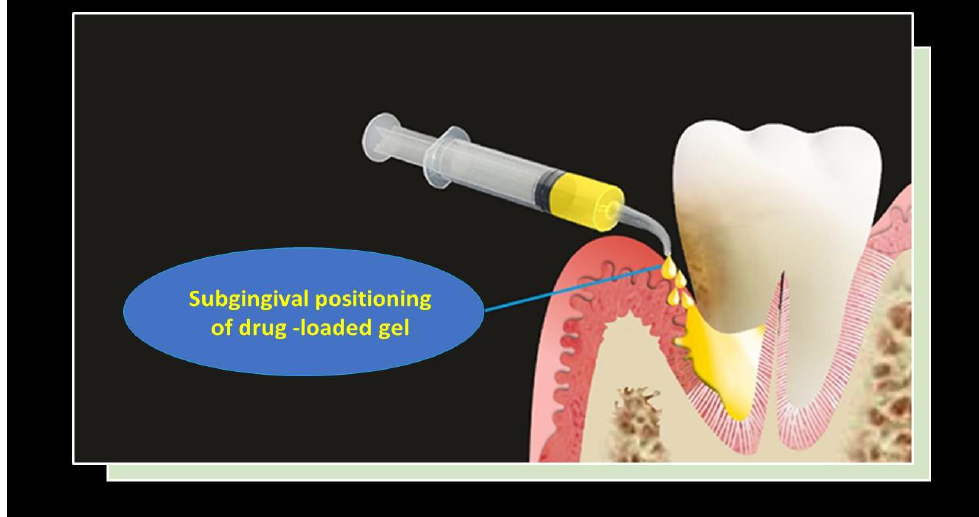
Figure 6. Gels and their placement. Reproduced with the permission from Rajeshwari et al. [32]. Various types of polymers, such as carbopol, carboxy methyl cellulose, and